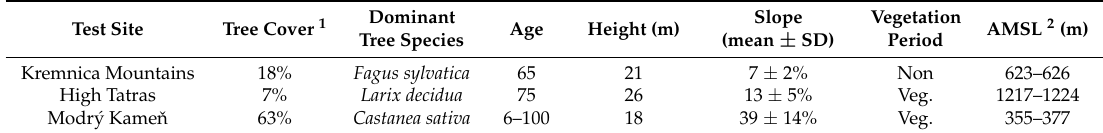
Figure 1. Location of the test plots. Table 1. Test plots characteristics.